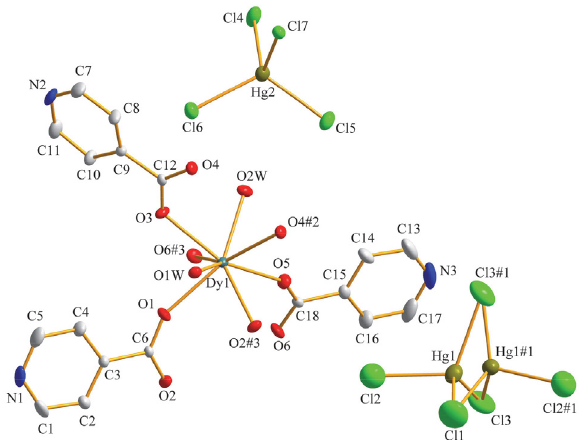
Figure 1. An ORTEP figure of compound 1 at 30% thermal ellip- soids. The lattice water molecules and H atoms have been omitted for